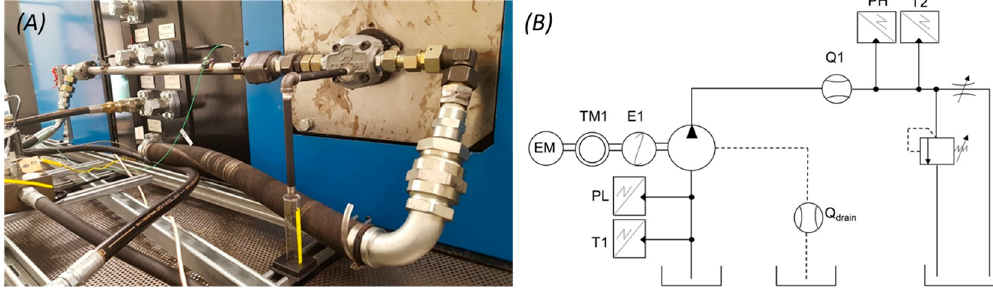
Figure 11. ( A ) Setup of the experimental test with the special prototype EGM and a graduated cylinder for measuring drain leakages. The drain leakages from the pump flow through the pipe connection leading to the measuring cylinder as shown in the figure; ( B ) ISO standard hydraulic circuit of the experimental setup used for measuring drain leakages. Table 1. Details of the different sensors and components used in the experimental test rig.